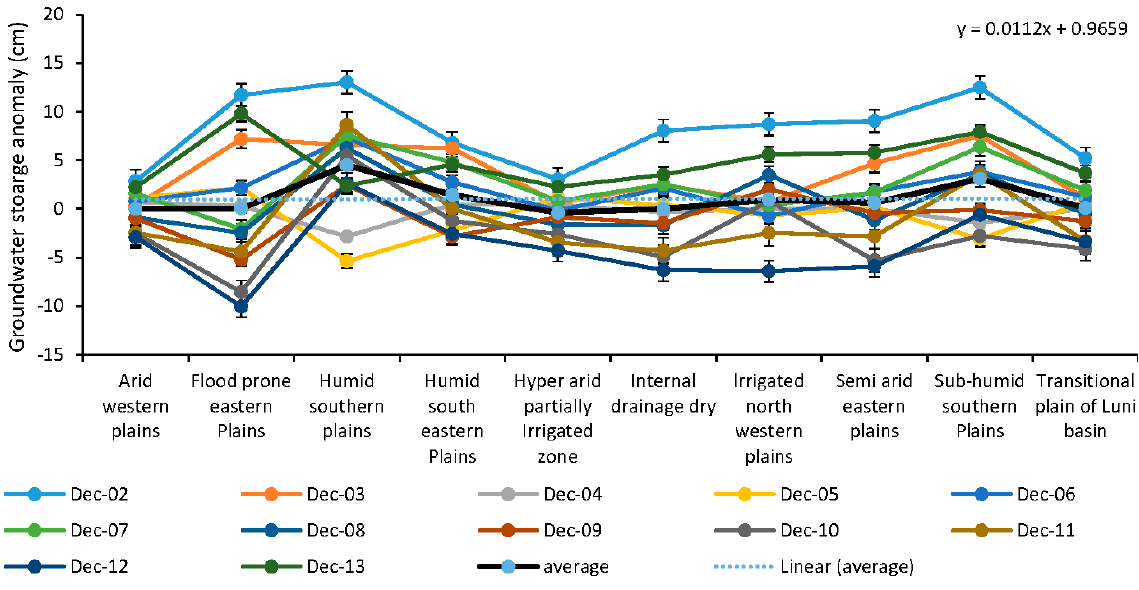
Figure 10. Variations in agroclimatic zonal GRACE estimates of groundwater storage anomaly in the Indian state of Rajasthan for the month of October. Bars indicate standard error.